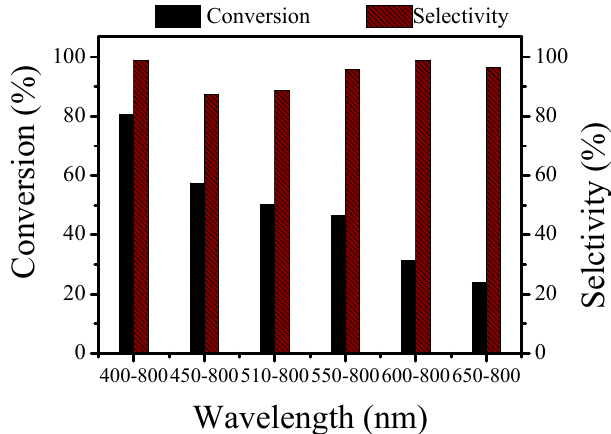
Figure 8. Effect of different light wavelengths on the reaction of benzyl alcohol and acetophenone. Figure 8. E ff ect of di ff erent light wavelengths on the reaction of benzyl alcohol and acetophenone.